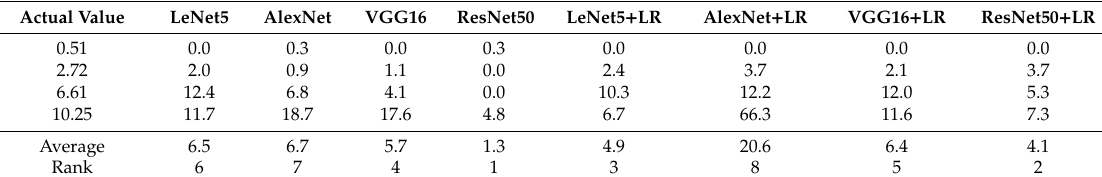
Table 4. Mean squared error (MSE) of the prediction model for each architecture.